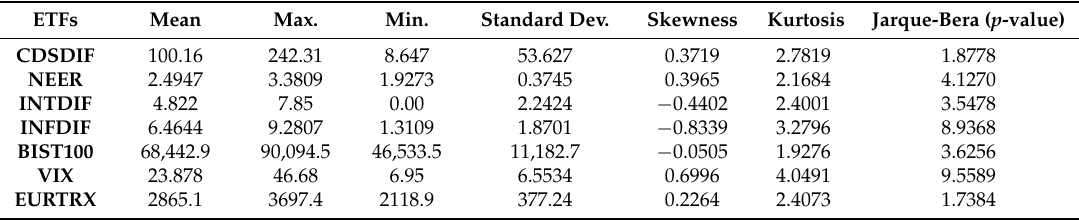
Table 1. Descriptive statistics of